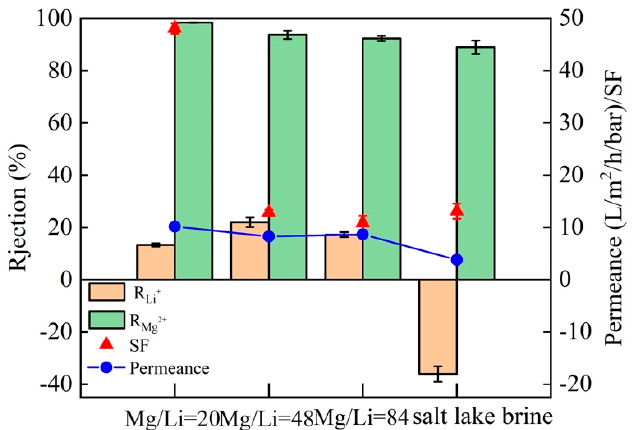
Figure 11. Separation performance and permeance of the M5 membrane in salt solution with different Mg 2+ /Li + ratios and salt lake brine solutions.